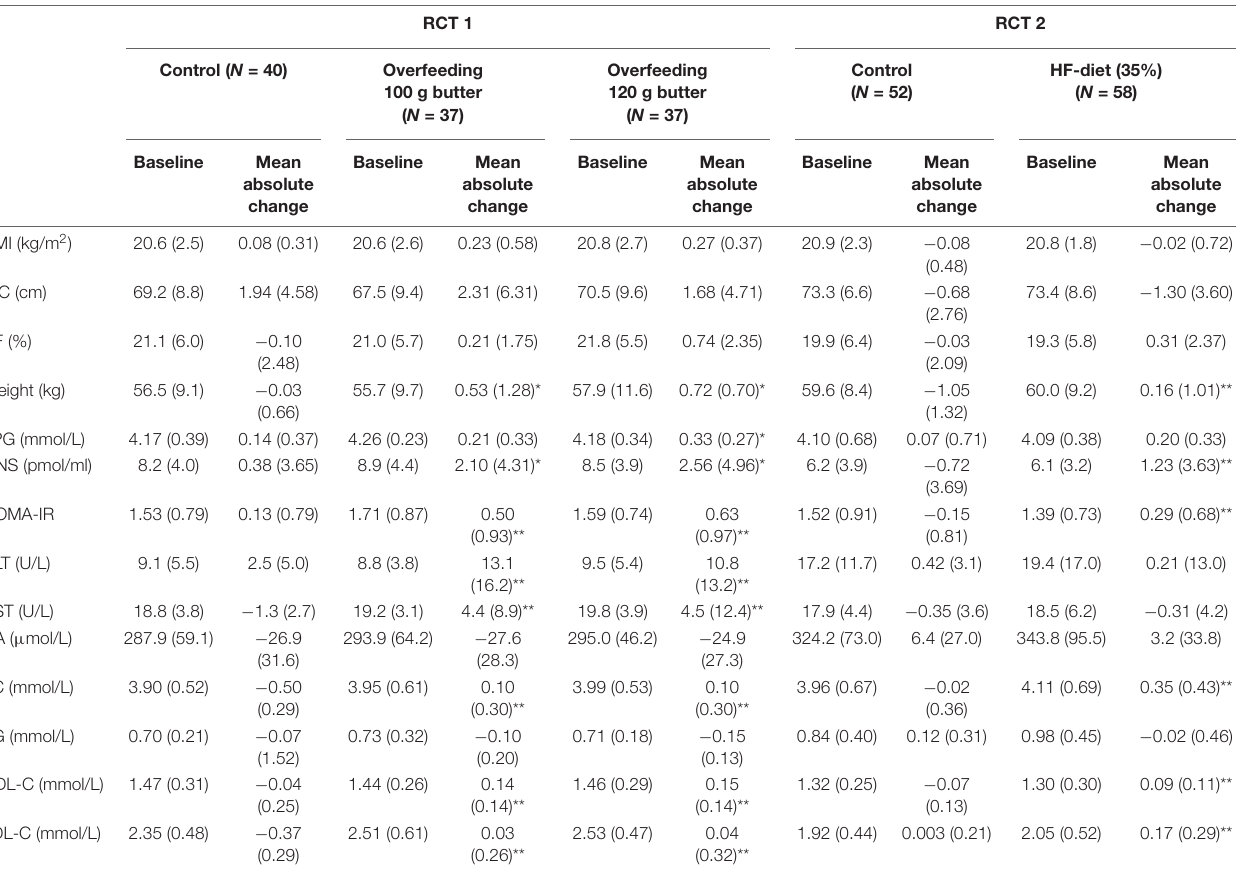
TABLE 1 | The anthropometric and biochemical indicators at baseline and mean absolute change after 1 week in the two RCTs. Control ( N = 40) Overfeeding